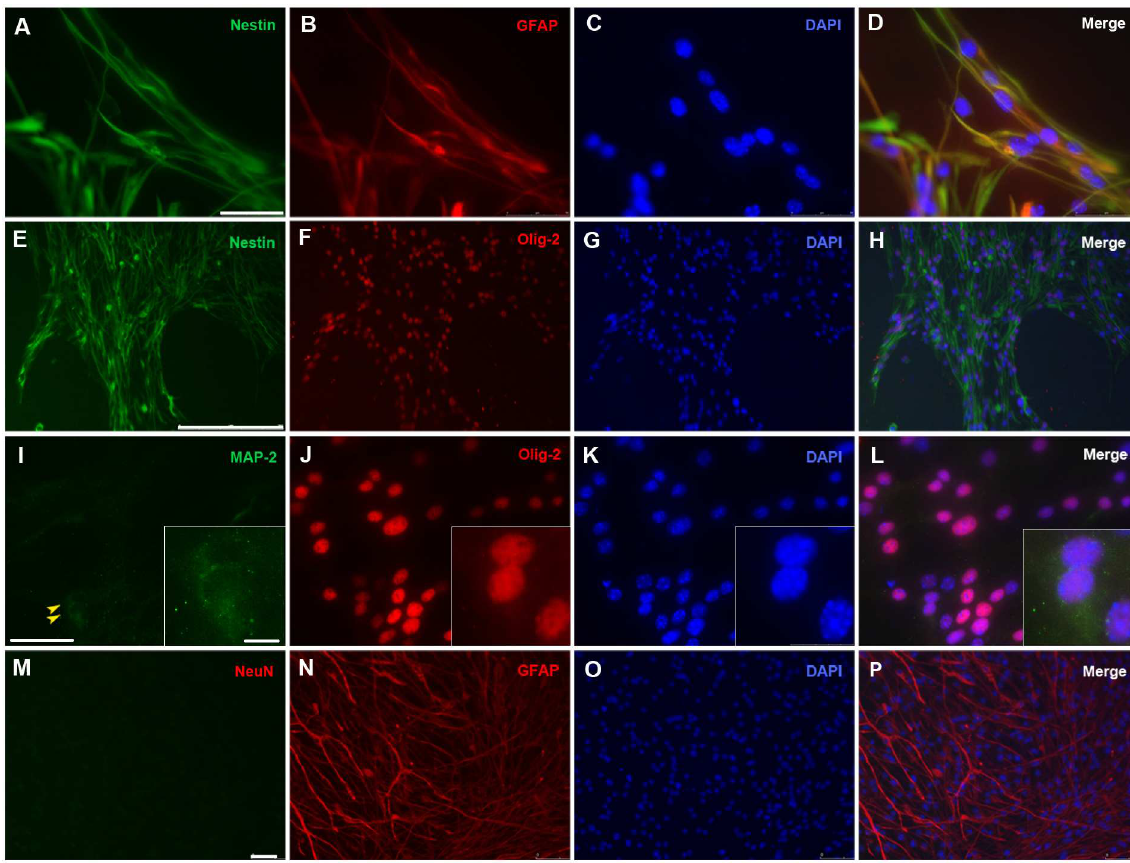
Fig 4. Immunocharacterization of in toto cryopreserved MGE-derived tissue in culture. Frozen-thawed in toto MGE-derived tissue was grown and allowedto expand on 0.1% gelatin-coated coverslipsfor 1 month in serum-free expansioncompletemedium. Cells were fixed and processedfor immunocytochemical stainingto identify different cellularphenotypes using a combination of markers. (A-D) nestin (green) in combination with glial fibrillaryacid protein (GFAP, red) as early markers expressedby immature precursors; (E-H) nestin (green) and the presence of Olig-2 (red), as early specific markers for MGE regionprecursors. (I-L) MAP-2 (green)for early neuronalmarker, the inset shows a highermagnification of the two cells pointedby arrowheads in which a low level accumulation of MAP-2 is detected; (M-P) Neu-N (green)as mature neuronalmarker and GFAP (red) as astrocytic marker; 4’-6’- Diamidino-2-phenylindole(DAPI) stain (blue) was used to visualizenuclei. Scale bars in A, I, and M: 50 μ m;in E: 250 μ m;in the inset: 10 μ